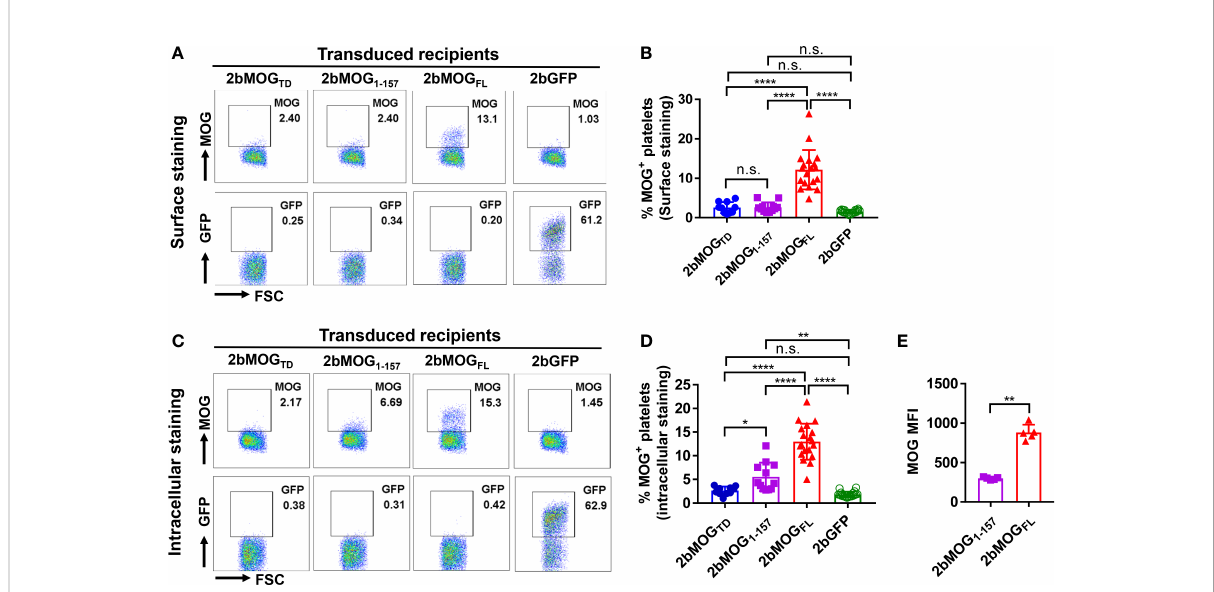
FIGURE 3 Platelet-MOG expression in 2bMOG-transduced recipients. Blood samples were collected from 2bMOG-transduced recipients after at least 3 weeks of BM reconstitution. Platelets were isolated, stained for CD41 and MOG with or without cell permeabilization, and analyzed by fl ow cytometry. 2bGFP was used as a control. (A) Representative dot plots from fl ow cytometry analysis by surface staining of MOG expression at 3 weeks after HSCT. (B) The percentages of MOG positive platelets in recipients by surface staining are shown. For individual mice analyzed more than once over the study, the average platelet MOG expression was calculated. (C) Representative dot plots from fl ow cytometry analysis by intracellular staining of MOG expression at 3 weeks after HSCT is shown. (D) The percentages of MOG positive platelets in indicated recipients by intracellular staining is shown. For individual mice analyzed more than once over the study, the average platelet MOG expression was calculated. (E) Representative mean fl uorescent intensity (MFI) of intracellular MOG expression in transduced recipients from one trial at 3 weeks after HSCT is shown. MOG MFI was analyzed by fl ow cytometry analysis through intracellular staining. *P < 0.05; **P < 0.01; ****P < 0.0001. “ n.s. ” indicates no statistically signi fi cant difference between the two groups. (B, D, E) Each data point represents one mouse. Data were summarized from four trials. MFI, mean fl uorescence